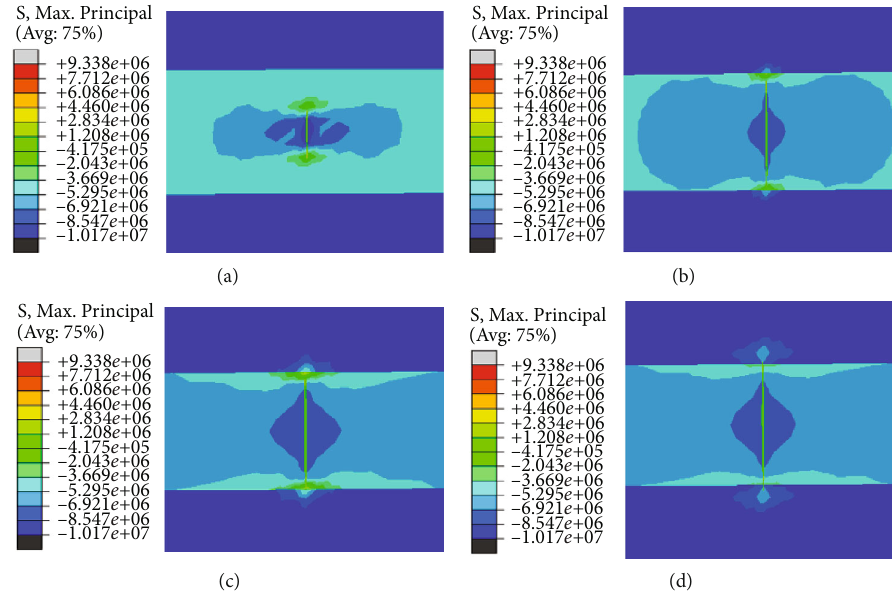
Figure 23: E ff ect of temperature on the development of hydraulic fracturing height for a range of temperature above 500 ° C along with the depth of the layers and at di ff erent times: (a) 10 steps, (b) 20 steps, (c) 40 steps, and (d) 50